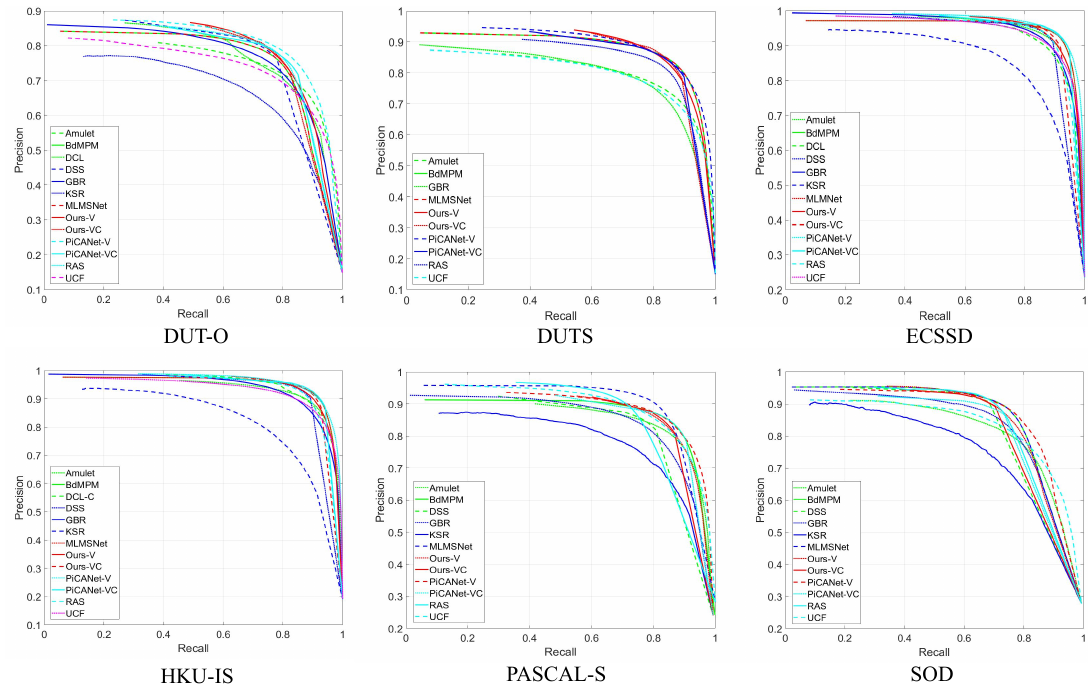
Figure 7. Comparison on six datasets in terms of the PR